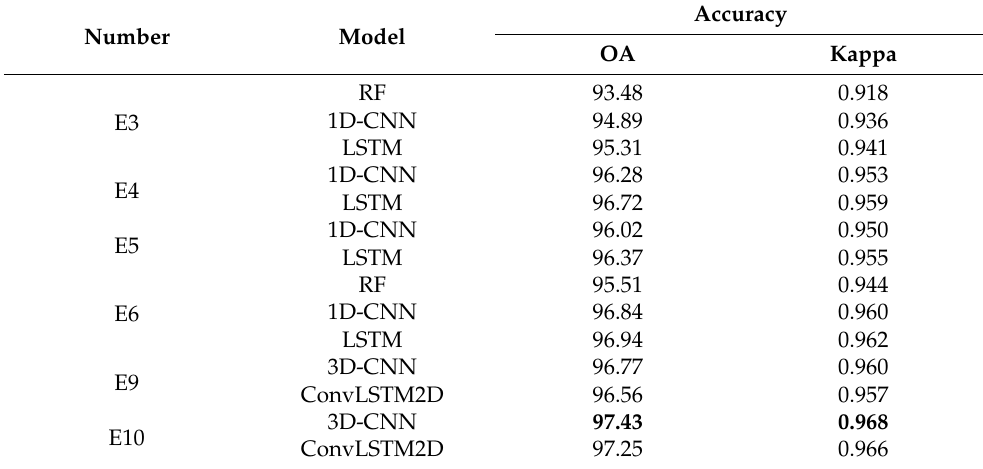
Table 6. Classification accuracy produced by various models and multi-spectral time-series